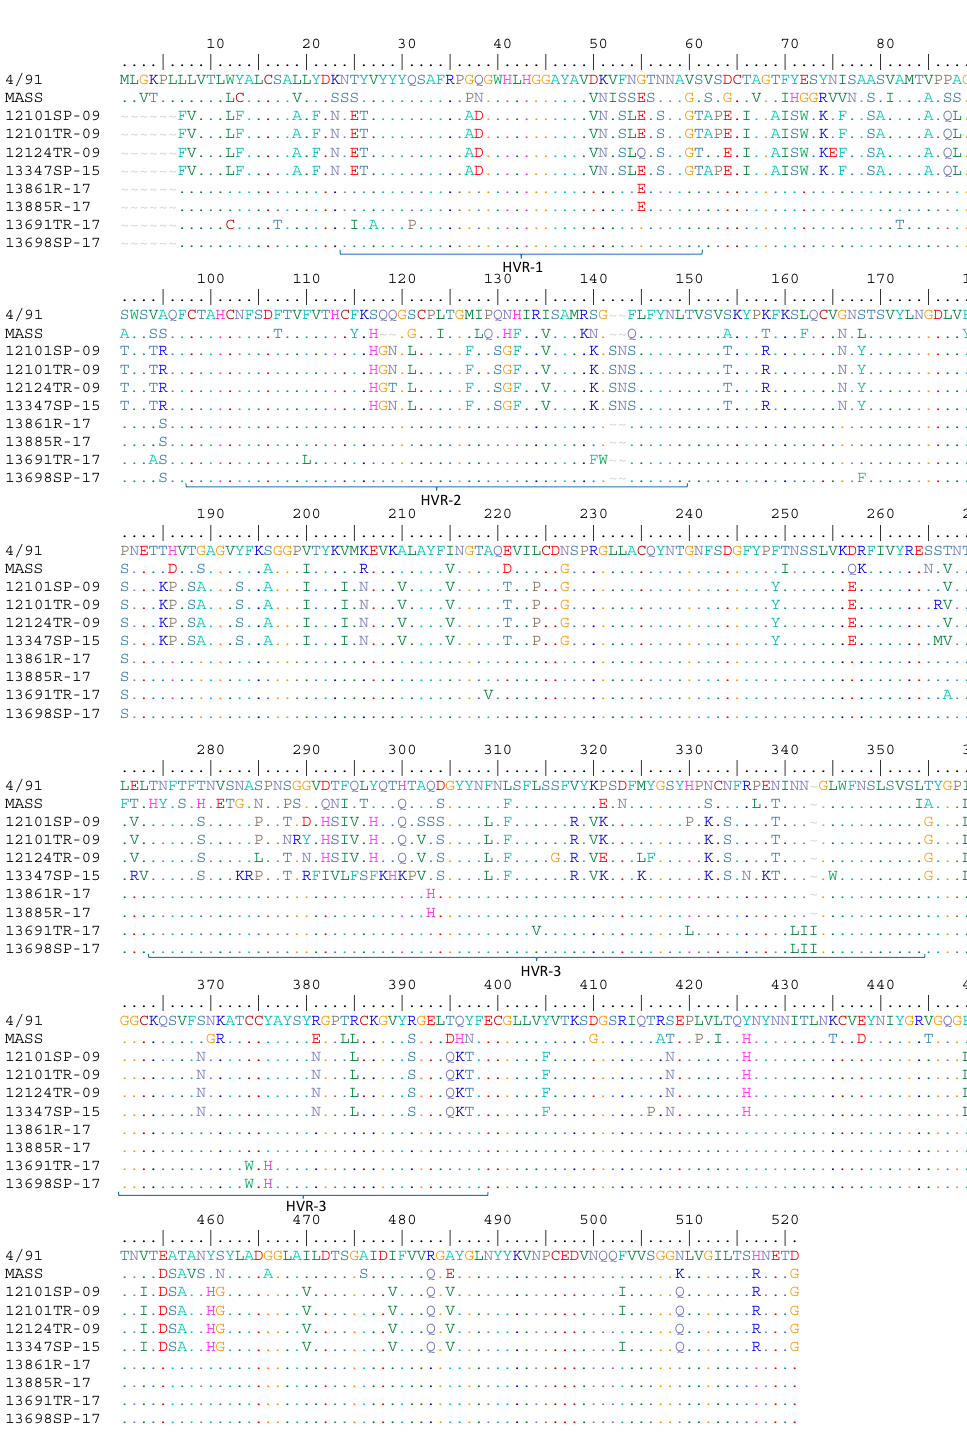
Figure 2. Amino-acid comparison of Mass and 4/91 vaccines with field strains from 2009, 2015 and 2017 along the entire S1 sequence performed with Bioedit software v7.2.5 [27]. Dots indicate the same amino acid in that position compared to the 4/91 vaccine.